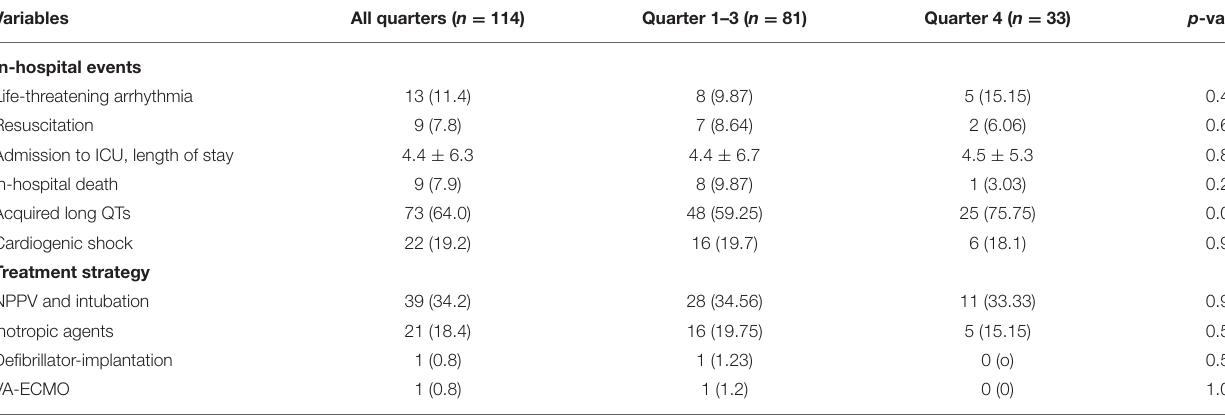
TABLE 2 | In-hospital events in TTS patients with events in the fourth quarter of year. Variables